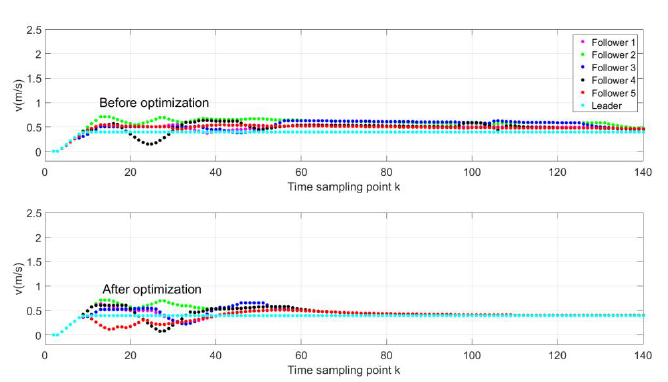
Figure 11. Velocity of cluster 1 before and after optimization. The figure above represents the speed changes of each AGV before optimization, while the figure below represents the speed changes of each AGV after